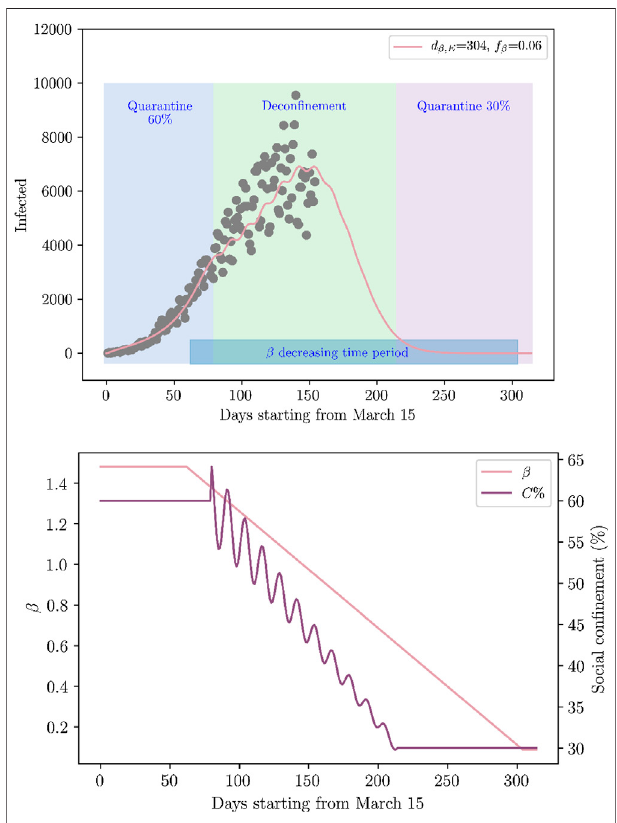
FIGURE 6 | Possible scenario to represent COVID-19 pandemic data. Pandemic data and model simulation (upper panel). Con fi nement lifting scheme and ß modi fi cation (lower panel). The percent of the population in con fi nement (%C) with Eq. 6 and social distance measures affecting the value of ß with Eq. 7 . These equations with parameter values at Table 2 represent a possible scenario to reconcile the pandemic data from June 1 till August 15.